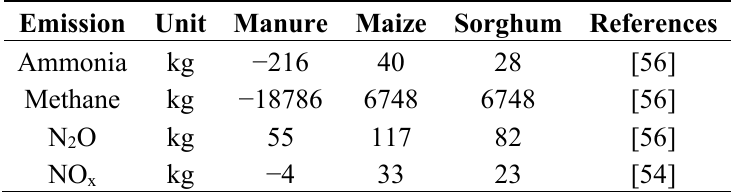
Table 3. Emissions from storage of digestate for open